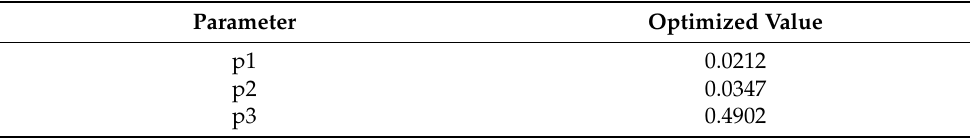
Table 3. Optimized values of decision tree